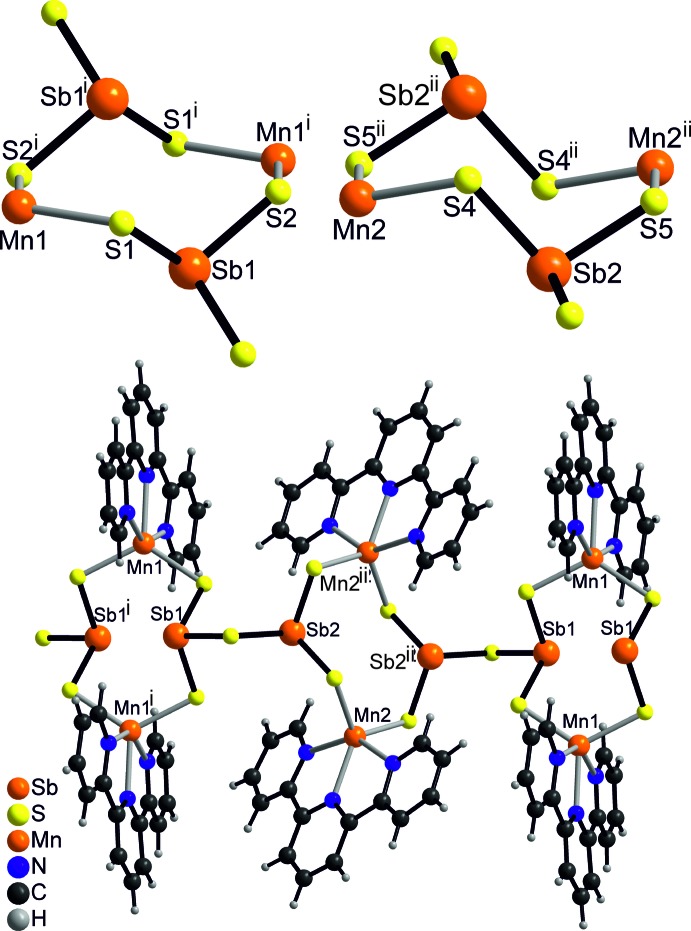
View of the eight-membered Mn2Sb2S4 rings for Mn1 (top: left) and Mn2 (top: right) as well as of the Mn2Sb2S5 chains (bottom). Symmetry codes used to generate symmetry-equivalent atoms: (i) −x + 1, −y + 1, −z + 1; (ii) −x + 1, −y + 1, −z + 2].